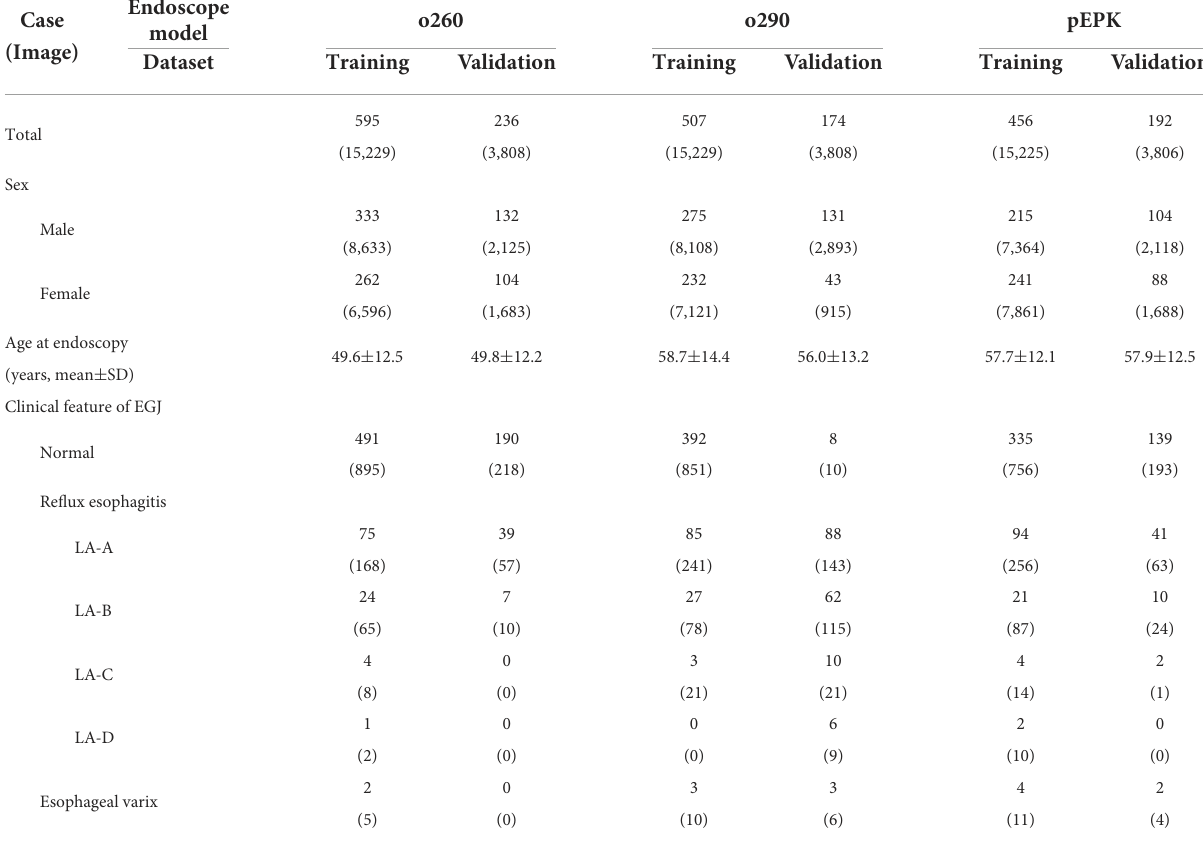
TABLE 1 Clinical characteristics of randomly distributed